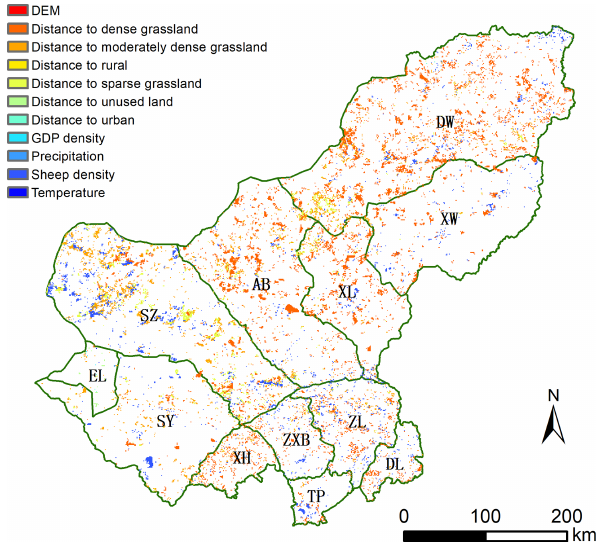
Figure 8. Spatial patterns of primary drivers for each pixel for NGD.